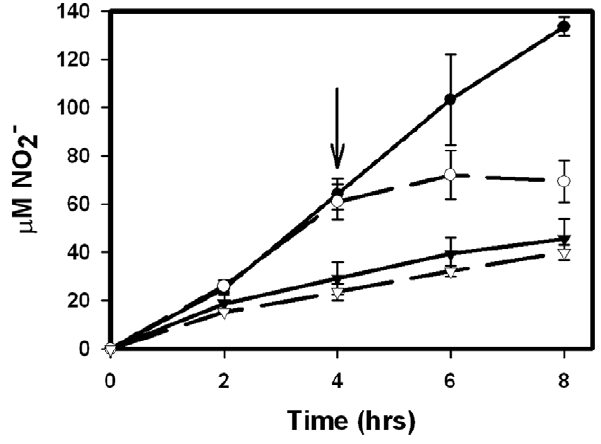
Figure 6. Oxygen inactivation of NarK2 but not NasA. Nitrite levels were determined in cultures of RVW3 pNarK2 (circles) and RVW3 pNasA (triangles). NRP-1 cultures were incubated anaerobically for 8 h (solid symbols), or anaerobically for 4 hrs, opened and then incubated aerobically for an additional 4 h (empty symbols). The arrow indicates when the cultures were shifted from anaerobic to aerobic conditions. The standard deviation is indicated.